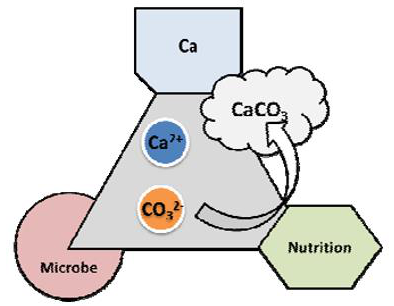
Figure 1. Basic constituents of bio-based repair materials.